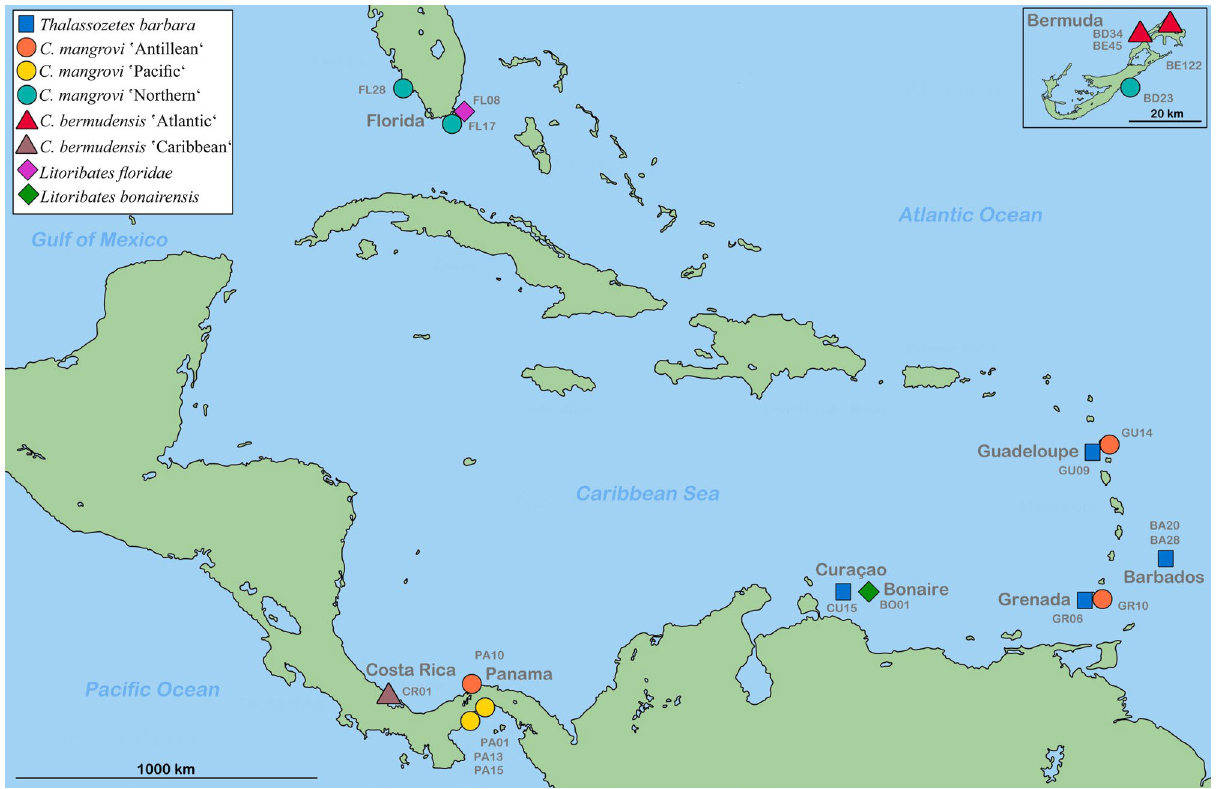
Figure 1. Map of the Caribbean highlighting the locations of investigated populations of Caribbean intertidal species. Genetic lineages of C. bermudensis and C. mangrovi indicated. Insert in the upper right corner showing the small island of Bermuda located in the Western Atlantic 1.600 km northeast to the coast of Florida. Codes (e.g. FL17) refer to location labels provided in Table 1. This map was created with the vector graphics editor Inkscape 0.92. (https ://inksc